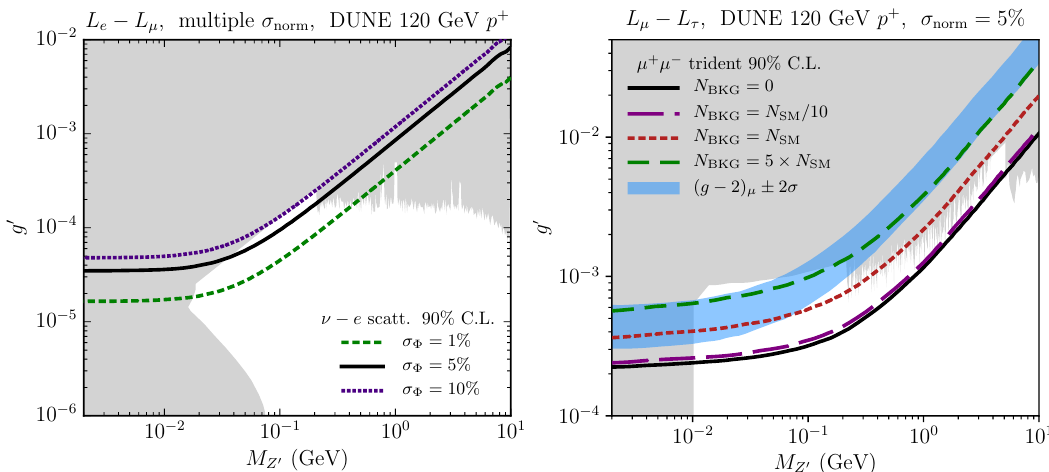
− L − L µ (left) and L µ τ (right) model with e